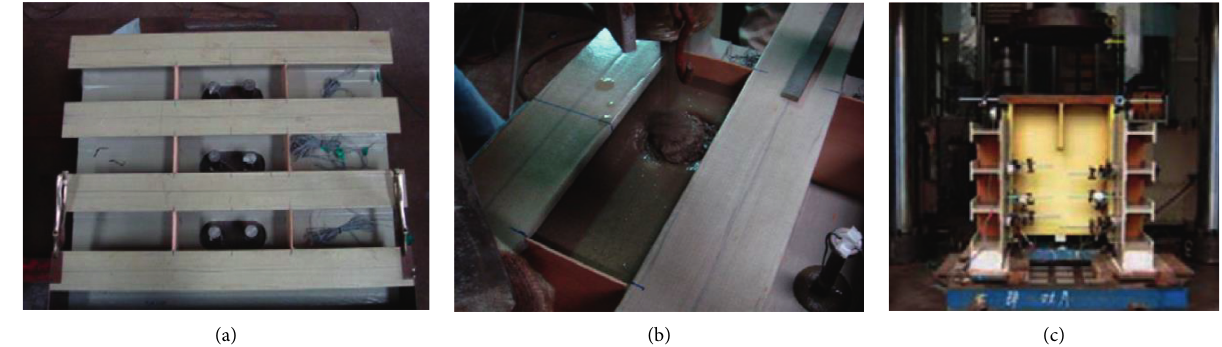
Figure 24: FRP deck-to-steel girders connection push-out test conducted by Cho. (a) FRP deck fabrication. (b) Grout pouring. (c) Test setup.